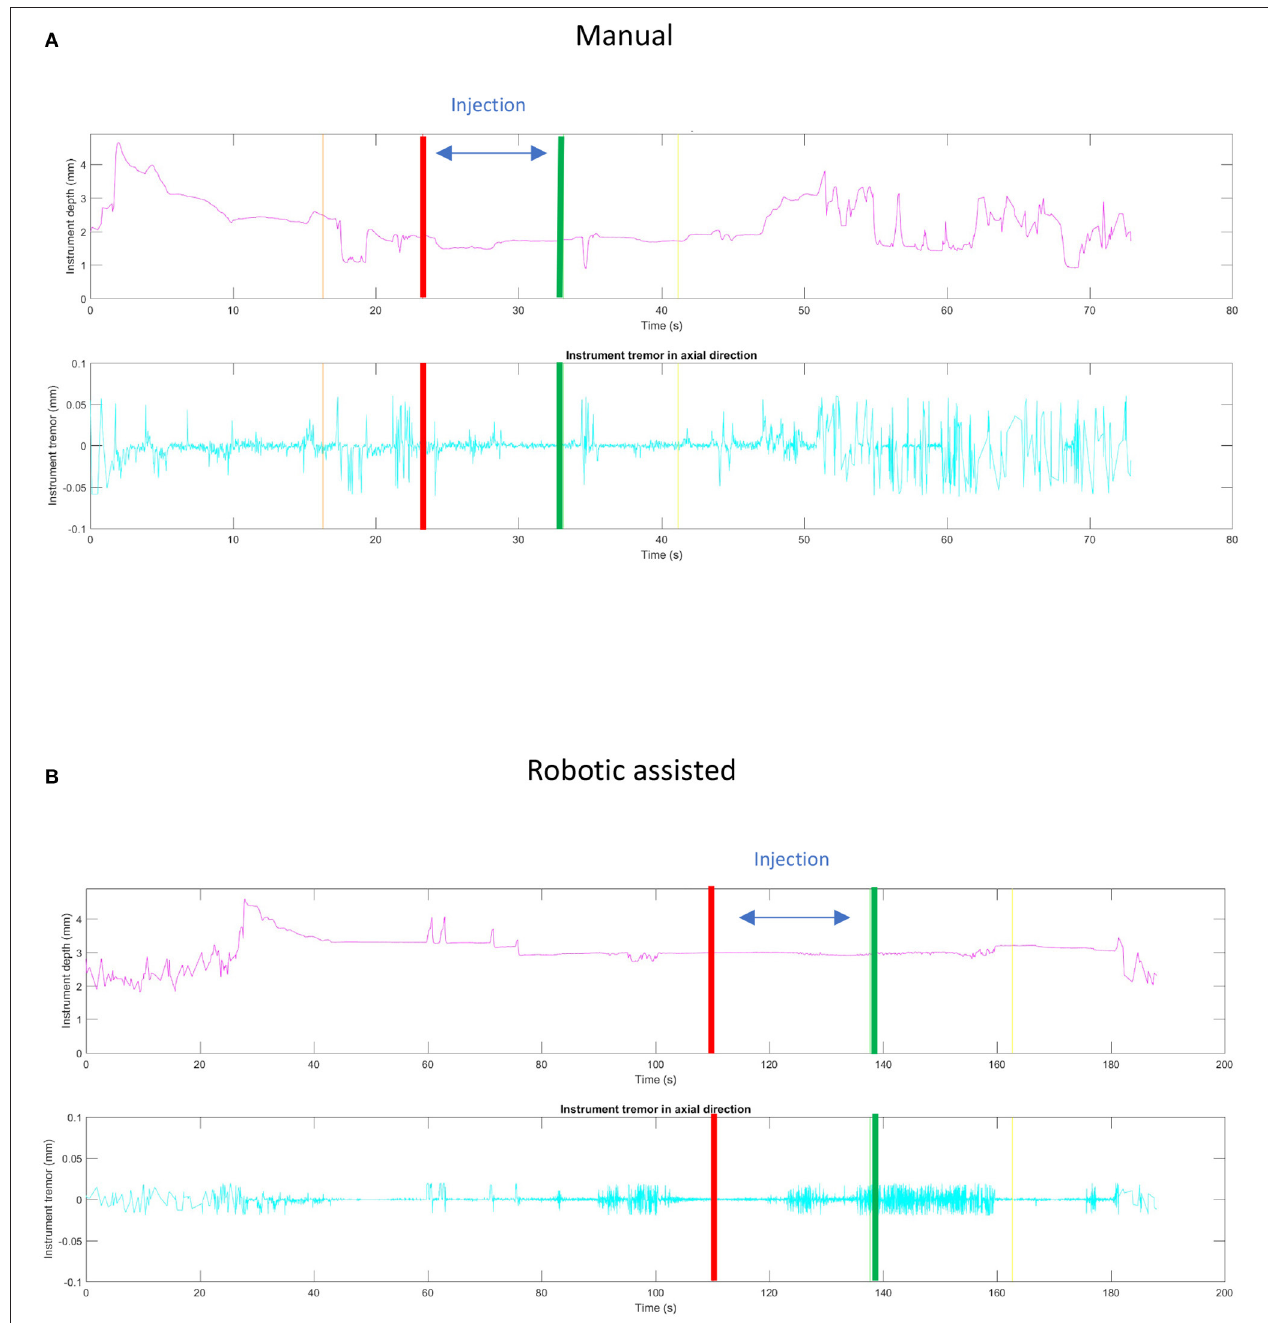
FIGURE 5 | Comparison of static stability between manual (A) and robotic assisted (B) simulated subretinal injections. The red and green lines correspond, respectively, to the beginning and the end of the fluid injection. The ability to hold the instrument steadily at the point of insertion during this maneuver was measured to deviate around 40–266 µ m, depending on the individual surgeon, when surgeries were performed manually as compared to a deviation of 1–2 µ m with robotic assistance. Note that spikes in the robotic assisted procedure measurement were due to artifacts.